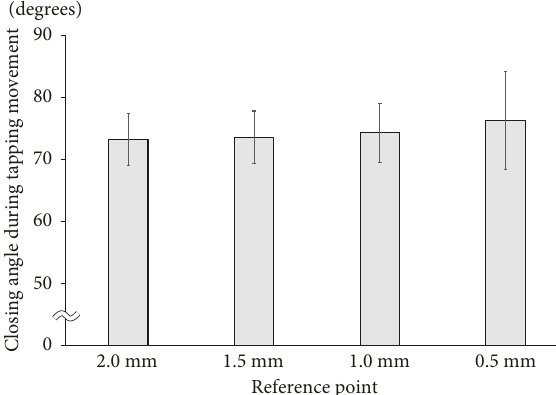
Figure 4: Closing angle during tapping